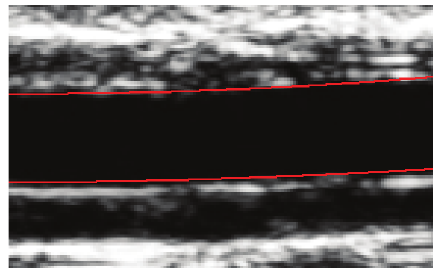
Figure 3: Search region for positioning the spline curve. Figure 4: Results: the modeling splines corresponding to the upper and lower boundaries are represented as red